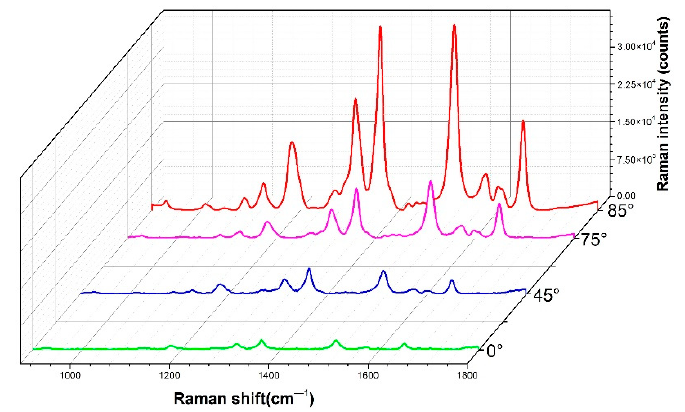
Figure 16. SERS performance obtained from the experiment.